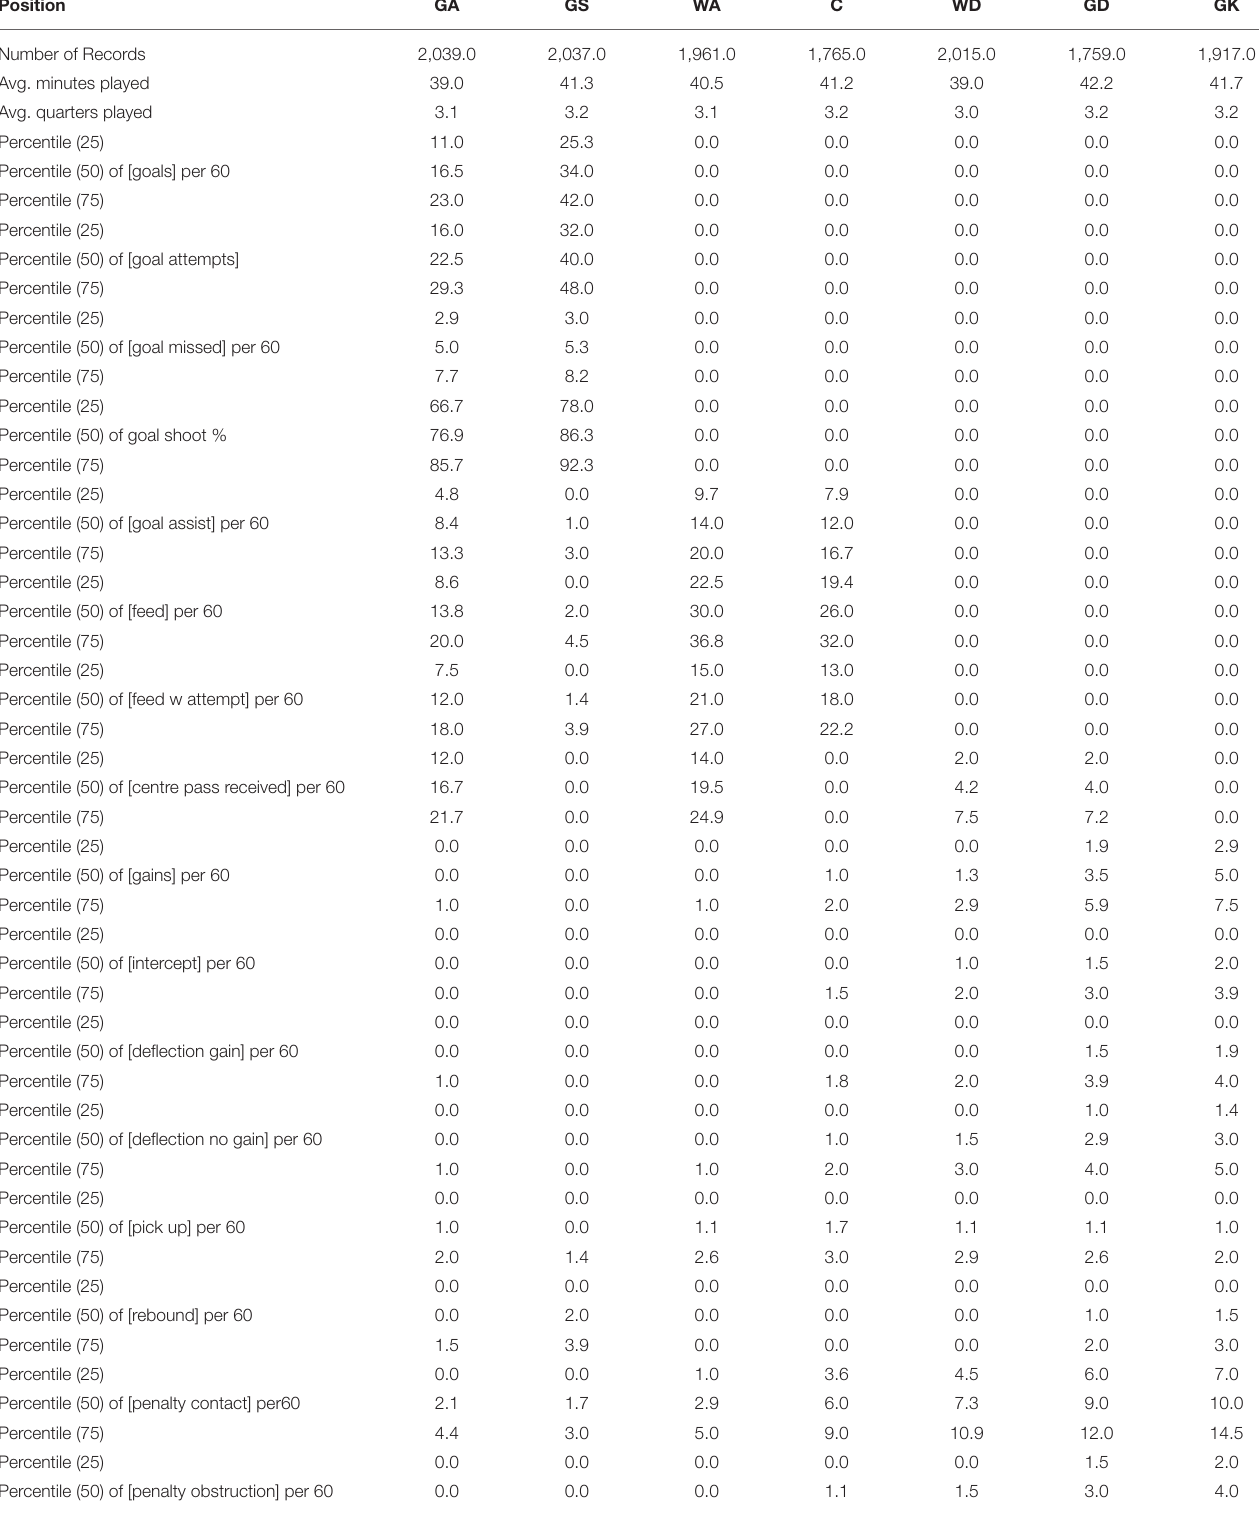
TABLE 1 | Combined normative data of international, national, and school level netball performance indicators. Position GA GS WA WD GD Number of